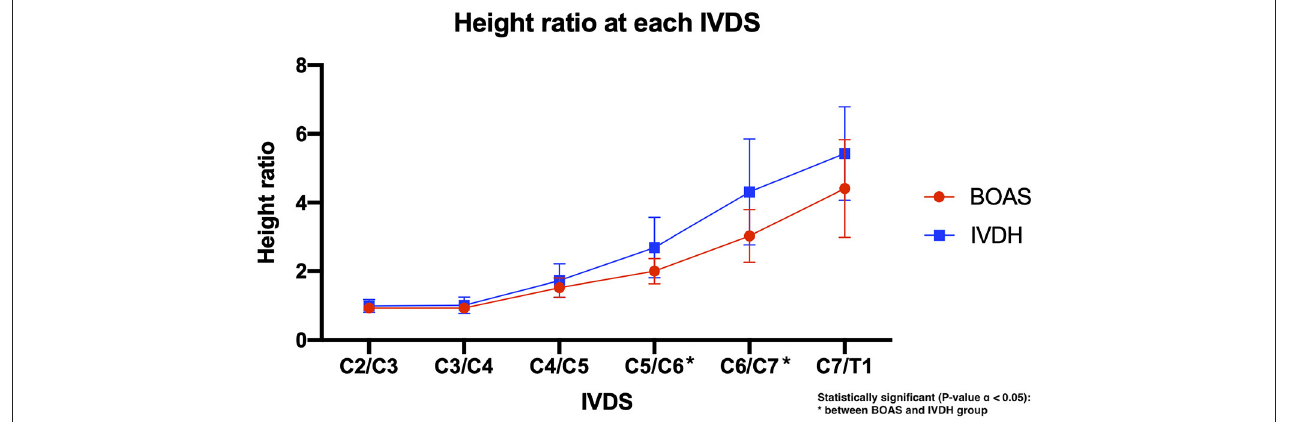
FIGURE 6 | Line graph showing the mean dorsal-to-ventral height ratio of the cervical paraspinal musculature in French bulldogs of the BOAS group (red line) and the IVDH group (blue line).